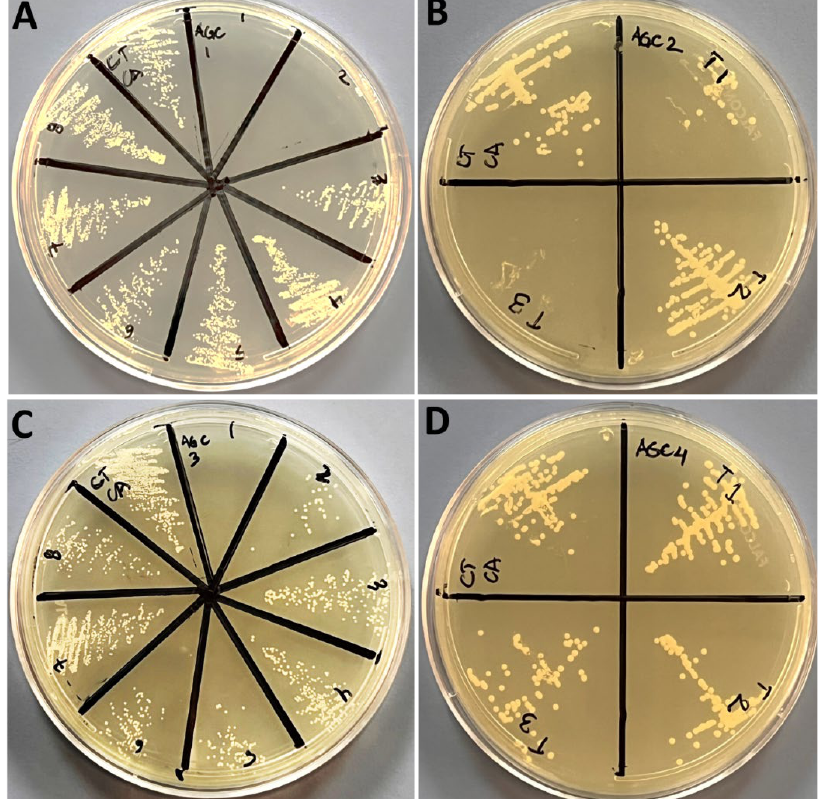
Figure 6. MFC (mg/mL) results of the NPs ( A ) Ag-C-1, ( B ) Ag-C-2, ( C ) Ag-C-3 and ( D ) Ag-C-4 against C. albicans .